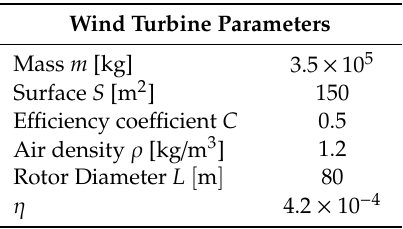
Table 1. Machine properties.